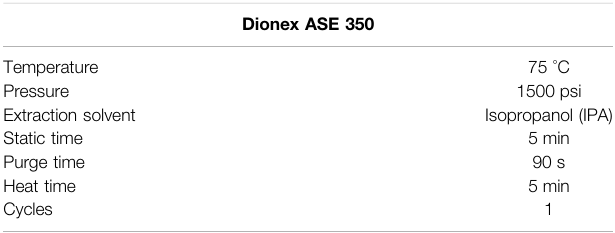
TABLE 1| Acceleratedsolventextractor (ASE)parametersforextracting terpenes from hops pellets and cannabis fl ower. Dionex ASE 350